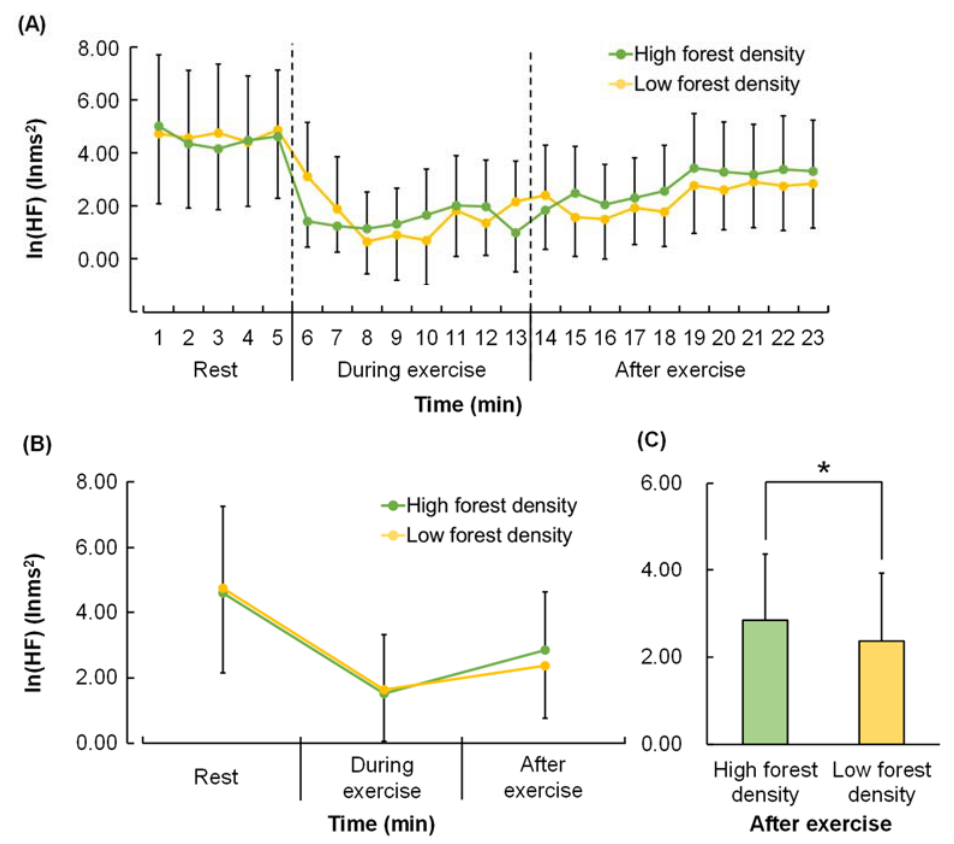
Figure 7. Changes in ln(HF) values of heart rate variability between high forest density and low forest density. It is divided into three periods: “rest”, “during exercise”, and “after exercise”. ( A ) Changes in each 1 ‐ min average ln(HF) values over the 23 ‐ min experiment. N = 12, mean ± standard error. ( B ) Changes in the average ln(HF) values in the three periods. N = 12, mean ± standard error. ( C ) Comparison of mean ln(HF) values “after exercise”. N = 12, mean ± standard error. * p < 0.05 using the paired t ‐ test.